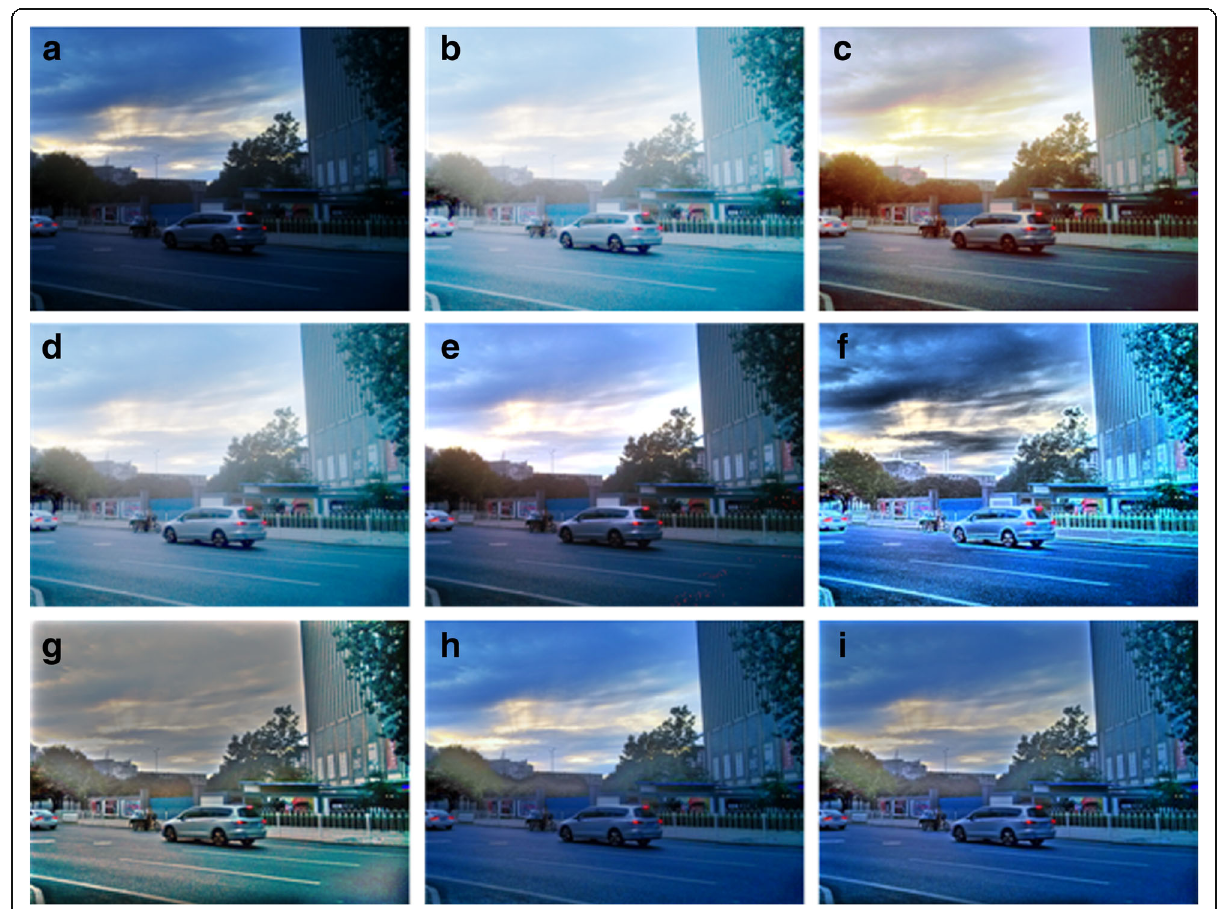
Fig. 8 Experimental results on settingsun. a Original image; b MSR; c LHE; d AL; e ALTM; f GUM; g SARV; h NPE; i